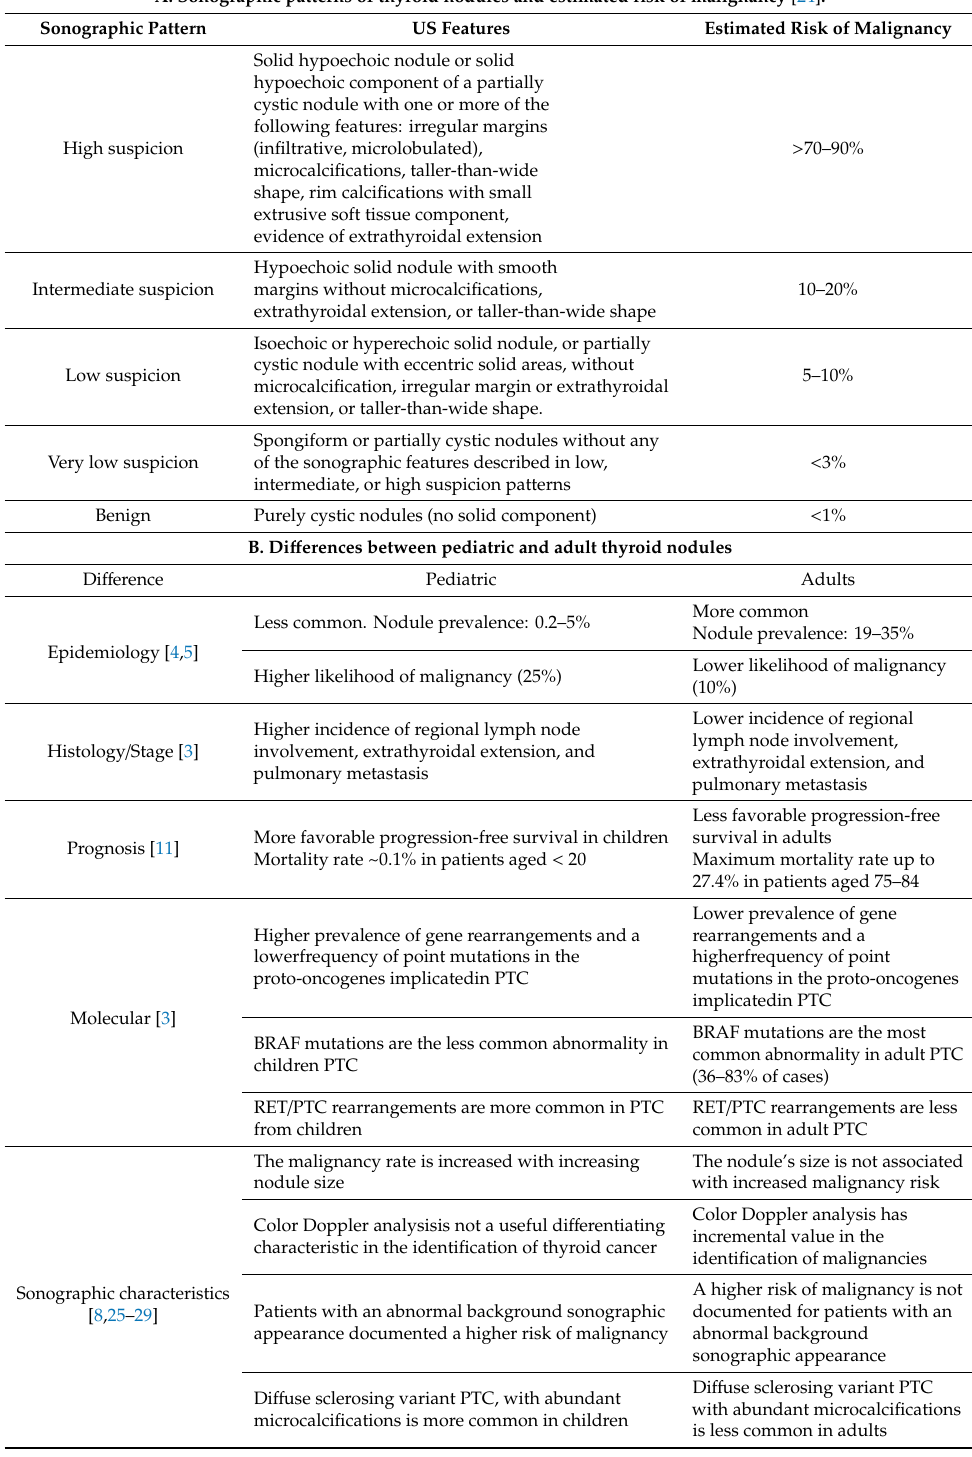
Table 2. Characters of thyroid nodules and di ff erences between children and adults thyroid nodules. A. Sonographic patterns of thyroid nodules and estimated risk of malignancy [24]